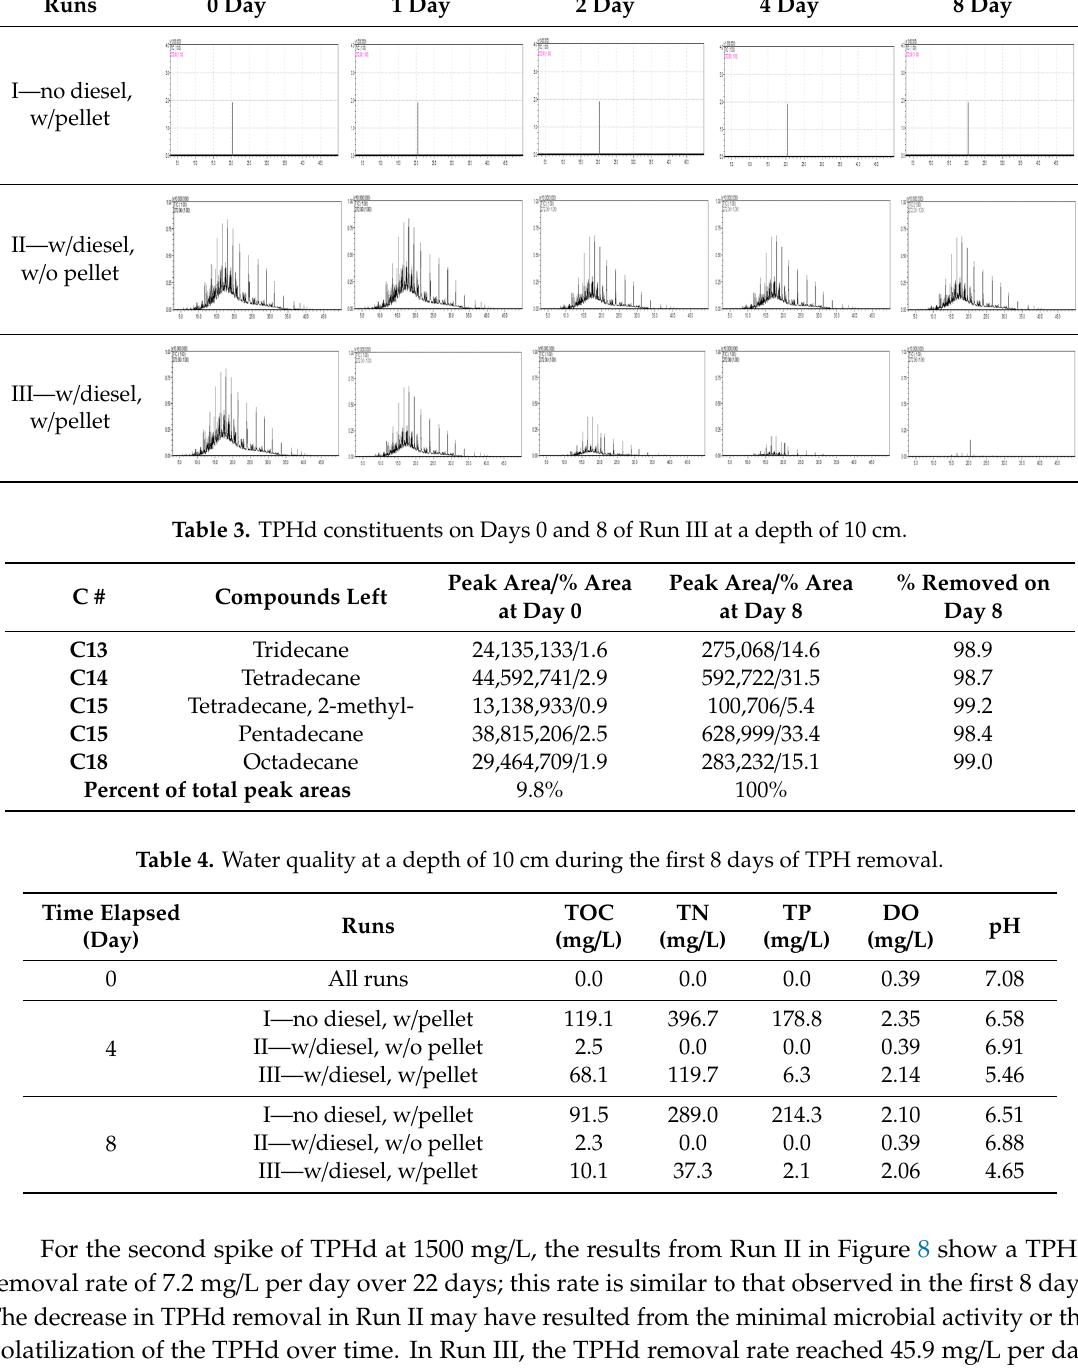
over the last 22 days, resulting in a 6-fold removal rate increase compared to that in Run II and strongly suggesting the feasibility of using manufactured biopellets for treating TPHd-contaminated